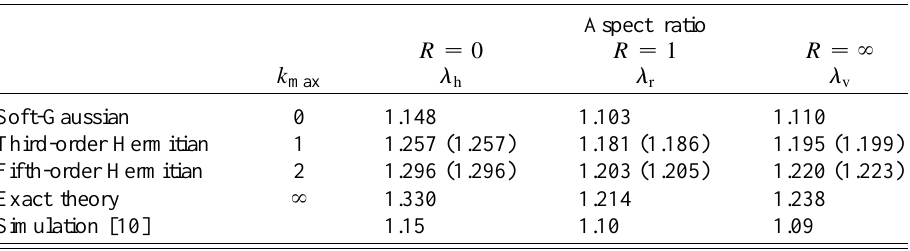
TABLE I. Eigenvalues for the equal-beam case.